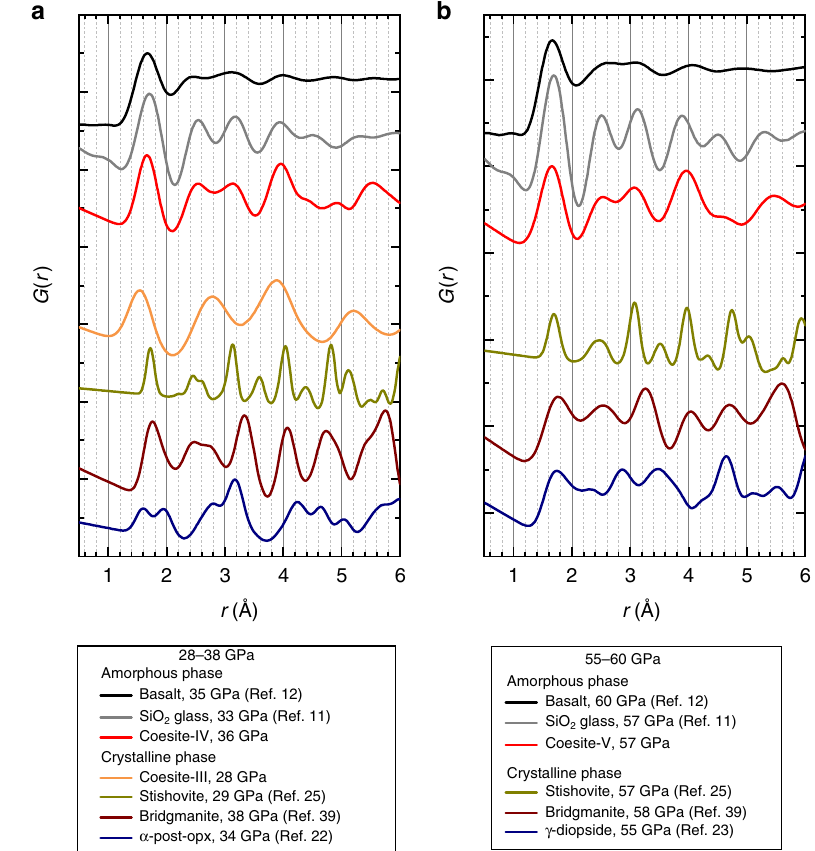
Fig. 3 Pair-distribution functions of silica and silicate phases. Solid curves represent pair-distribution functions calculated for silica polymorphs (this work and ref. 25 ) and silicates 22,23,39 , compared with those for basalt 12 and silica 11 glass measured at different pressures: a , in the range from 28 to 38 GPa; b , in the range from 55 to 60